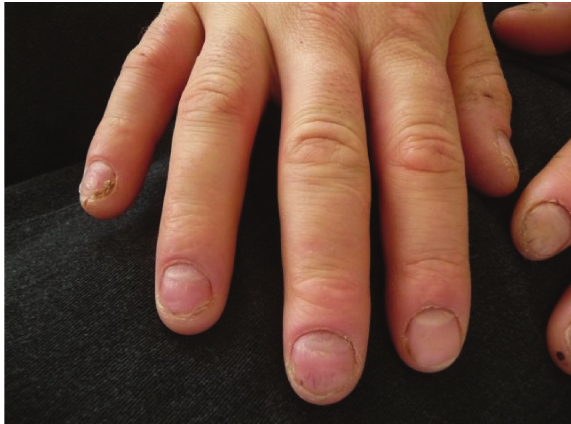
Figure 2: Fingernails after the second infusion of